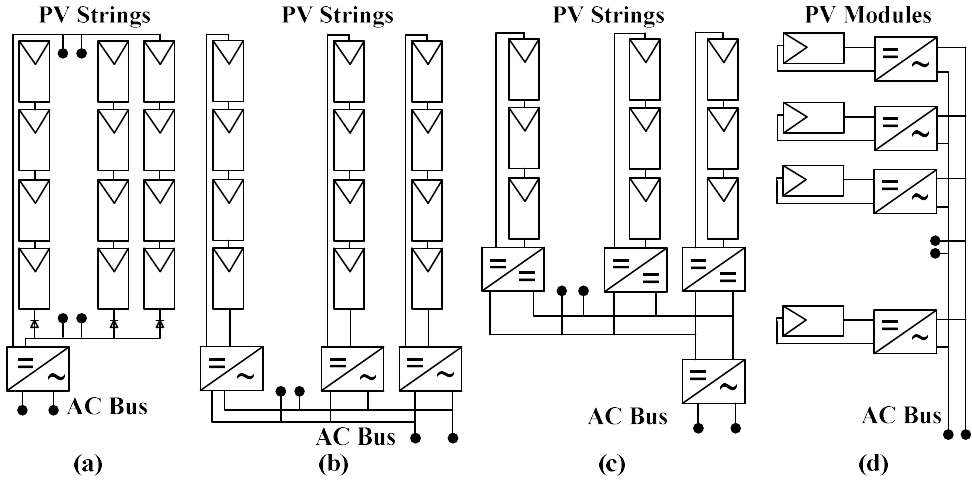
Figure 4. Configuration of grid-connected PV inverters: ( a ) central; ( b ) string; ( c ) multi-string; and ( d ) AC modules [45].